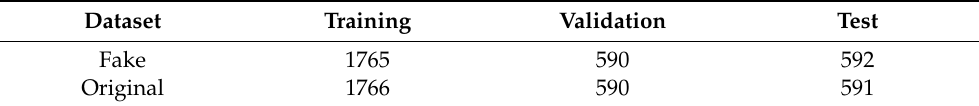
Table 5. Distribution of the unified dataset: training, validation, and